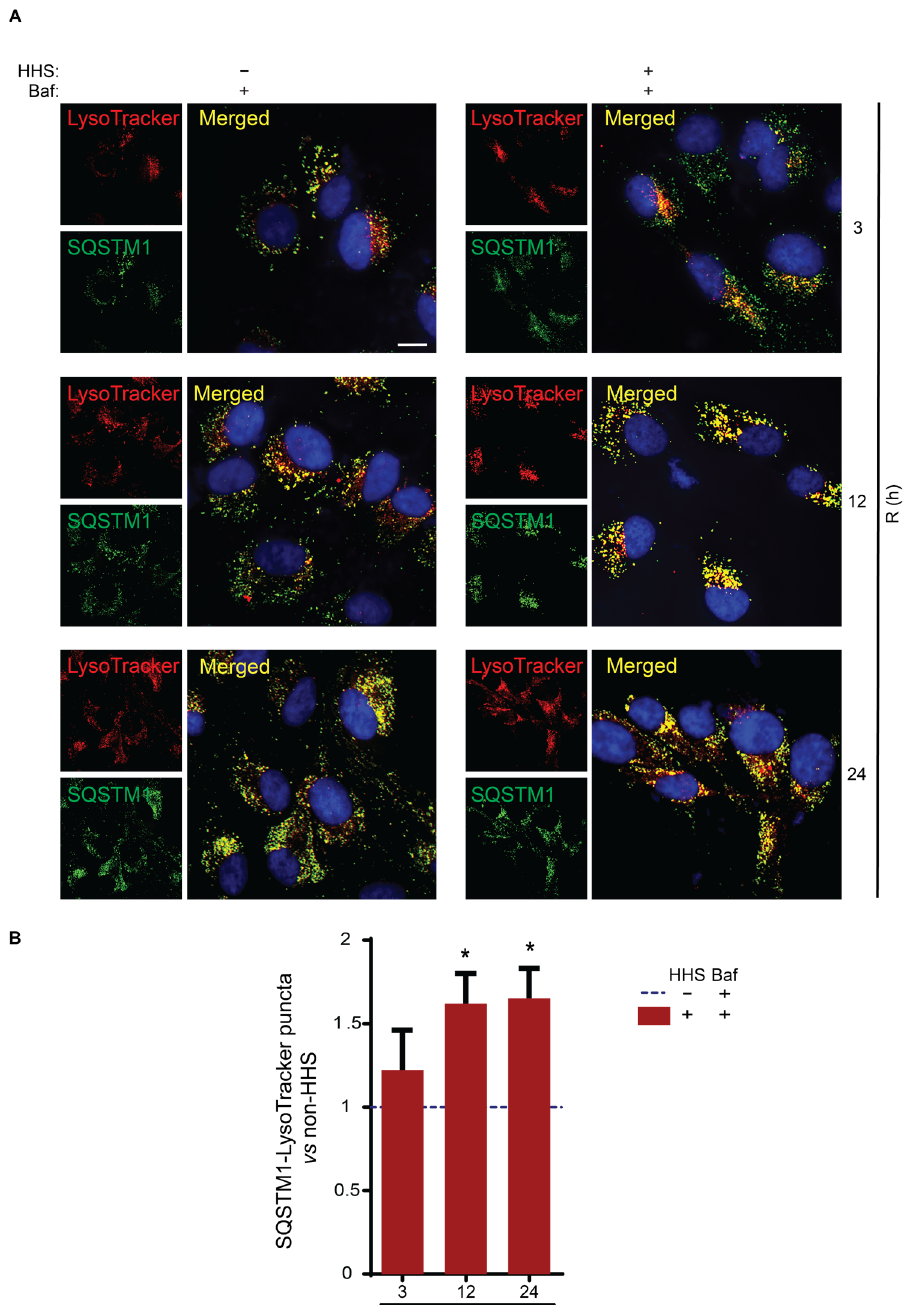
Figure 7. Hormetic heat shock enhances SQSTM1-associated cargo presentation to lysosome. ARPE- 19 cells were exposed initially for 6 h to 50 nM Bafilomycin (Baf); then, cells were treated without HHS (–) or with 30 min HHS (+) at 42 ◦ C, followed by recovery at 37 ◦ C in the presence of Baf. Cells were exposed to LysoTracker during the final 2 h treatment. ( A ) Colocalization of SQSTM1 (green) with LysoTracker (red) was examined by IF. Cells’ nuclei were counterstained with Hoechst (blue). ( B ) The number of yellow puncta (scored as colocalized SQSTM1-LysoTracker) was counted per sample, and quantitative analysis was normalized to Non-HHS/Baf, represented as dashed line (—). Data are shown as mean ± SEM ( n = 60). Statistical analysis was performed using one-way ANOVA, followed by Sidak test (* p < 0.05). Scale bar = 20 µ